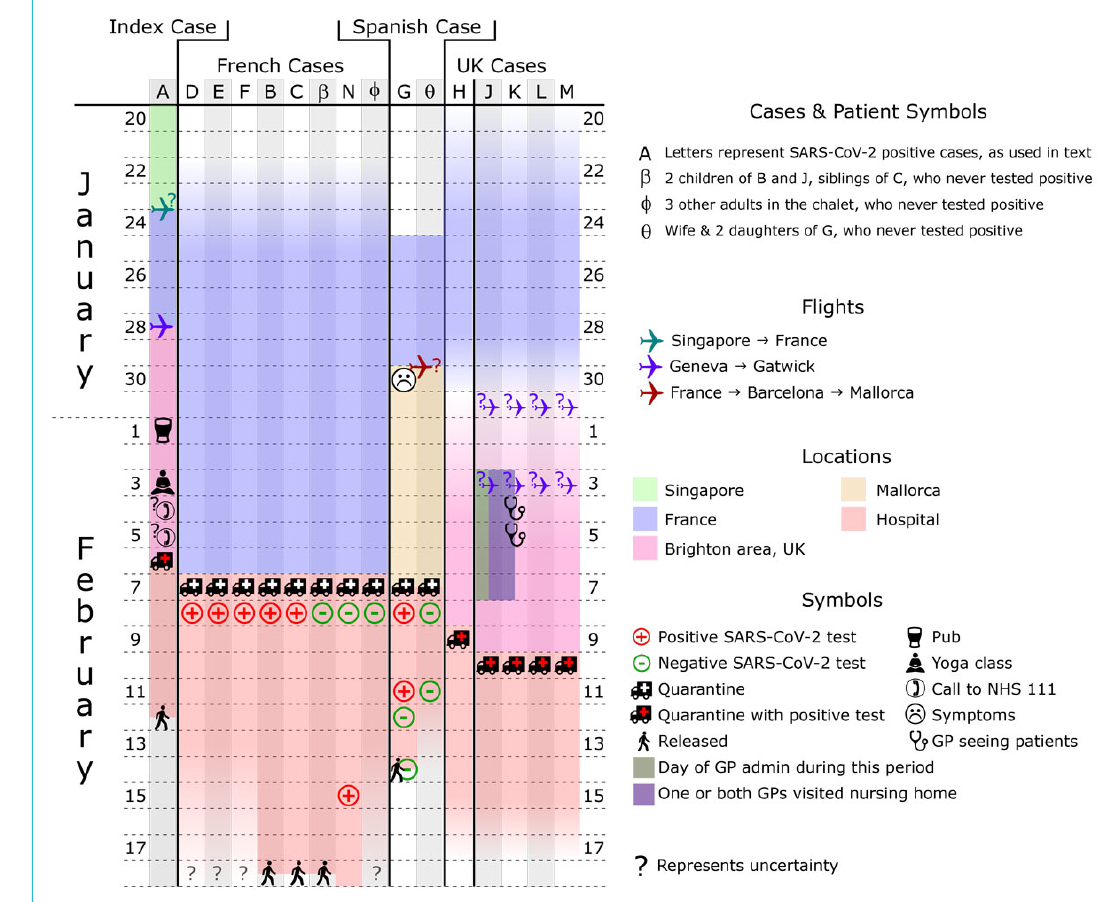
Figure 2: This detailed figure includes almost all information that is provided in the text, including travel and quarantine time, diagnoses and additional tests (if available), release date, and other important activities. Greek letters are used to represent multiple people who never tested positive for SARS-CoV-2. Questions marks show uncertainty about when or for whom an event occurred. Shading in the location colours con- veys uncertainty about when individuals travelled, when they were present in a location, and by extension, when they overlapped with other in-